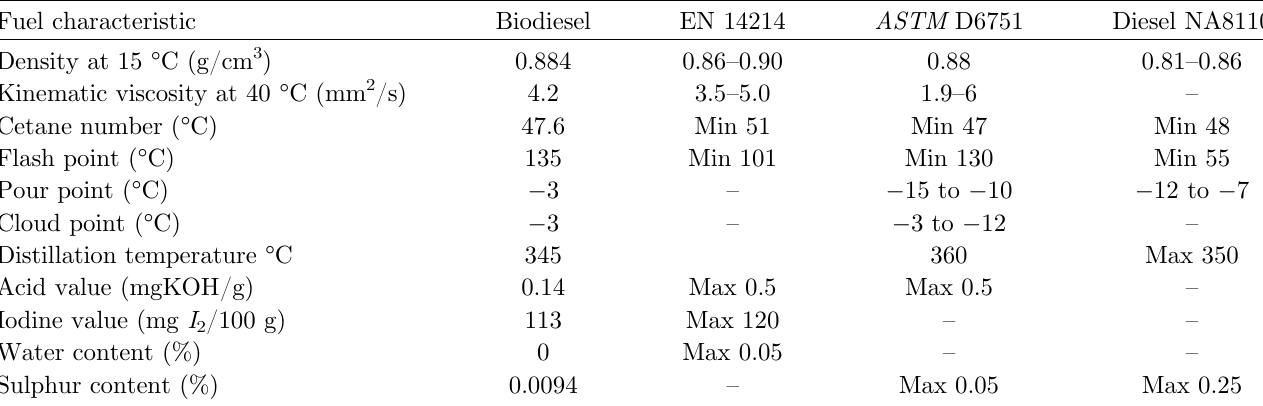
Table 6. Fuel characteristics of FAEE/ ASTM D6751 – EN 14214 [54] and Diesel